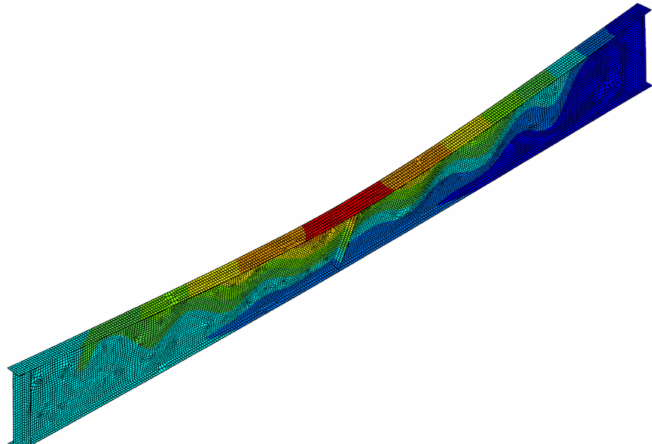
Figure 20. Failure mode—beam B3, scale × 2.